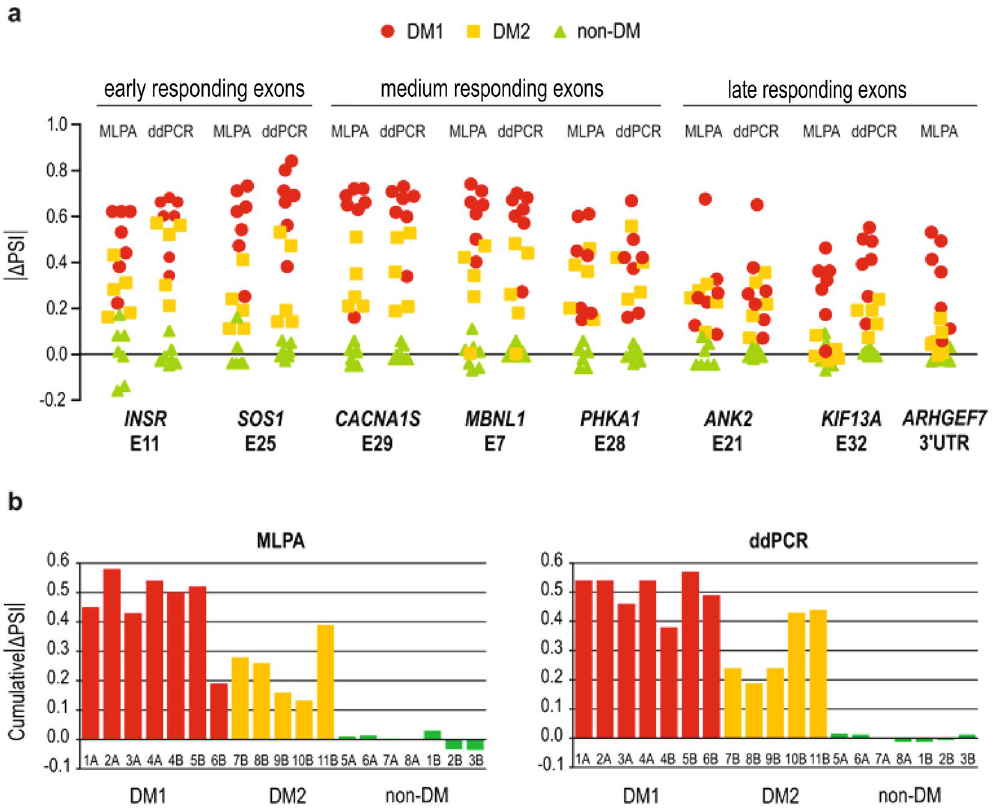
Figure 4. Aberrant Alternative Splicing Analysis with ddPCR and MLPA Assays. ( a ) MLPA and ddPCR results of aberrant alternative splicing for three categories of exons in DM1, DM2 and non-DM samples of human skeletal muscles. For each gene, exon inclusion rate (PSI, the percent of splice in) was calculated and normalized to the average PSI value for non-DM samples, resulting in the delta PSI value for each DM sample. ( b ) Average cumulative results of | Δ PSI| values for DM1, DM2 and non-DM human skeletal muscles (shown in panel a) obtained with MLPA and ddPCR are shown. For two (6B and 10B) out of twelve samples the | Δ PSI| showed some discrepancy between MLPA and ddPCR methods what was correlated with poor RNA quality of these